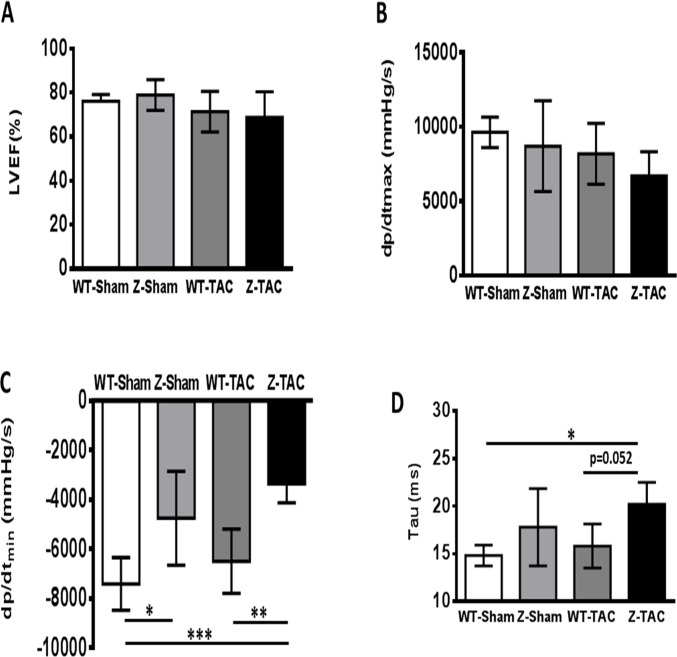
Rat LV function assessed by PV loop. LV systolic function indexes: (A) Left ventricular ejection fraction (LVEF), (B) dp/dtmax. LV diastolic function indexes: (C) dp/dtmin and (D) Tau. (*: p<0.05; **: p<0.01; ***: p<0.001.